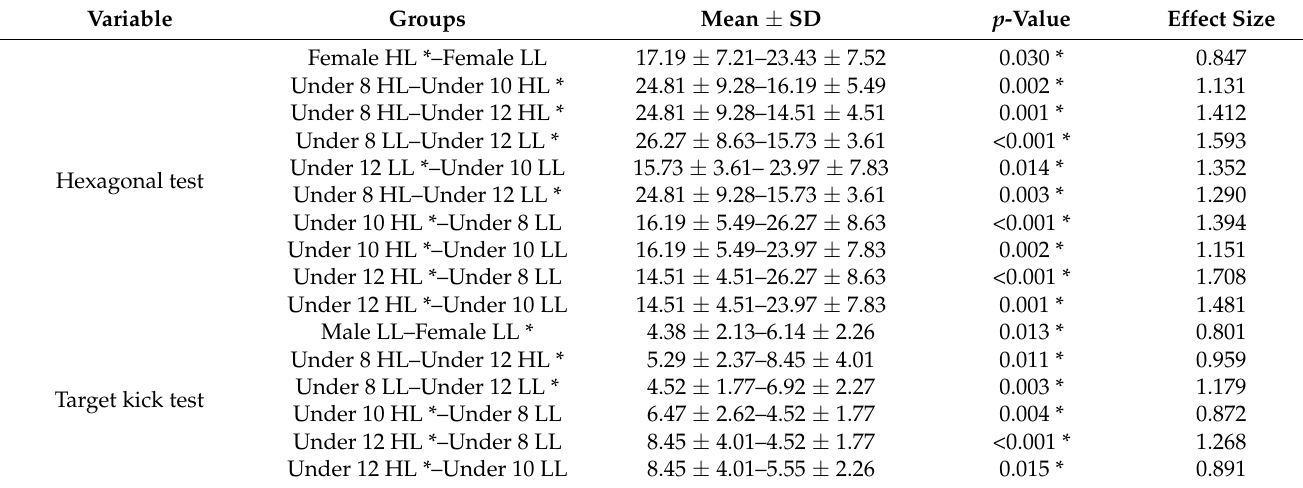
Table 5. Comparison between technical level, gender and age in the hexagonal test and target kick test (n = 115).